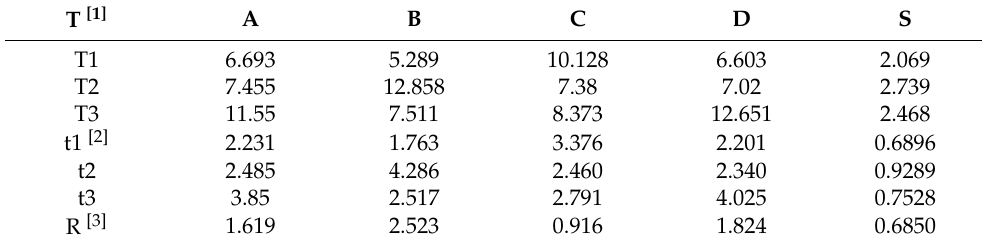
Table 4. Data analysis for the various experimental factors.